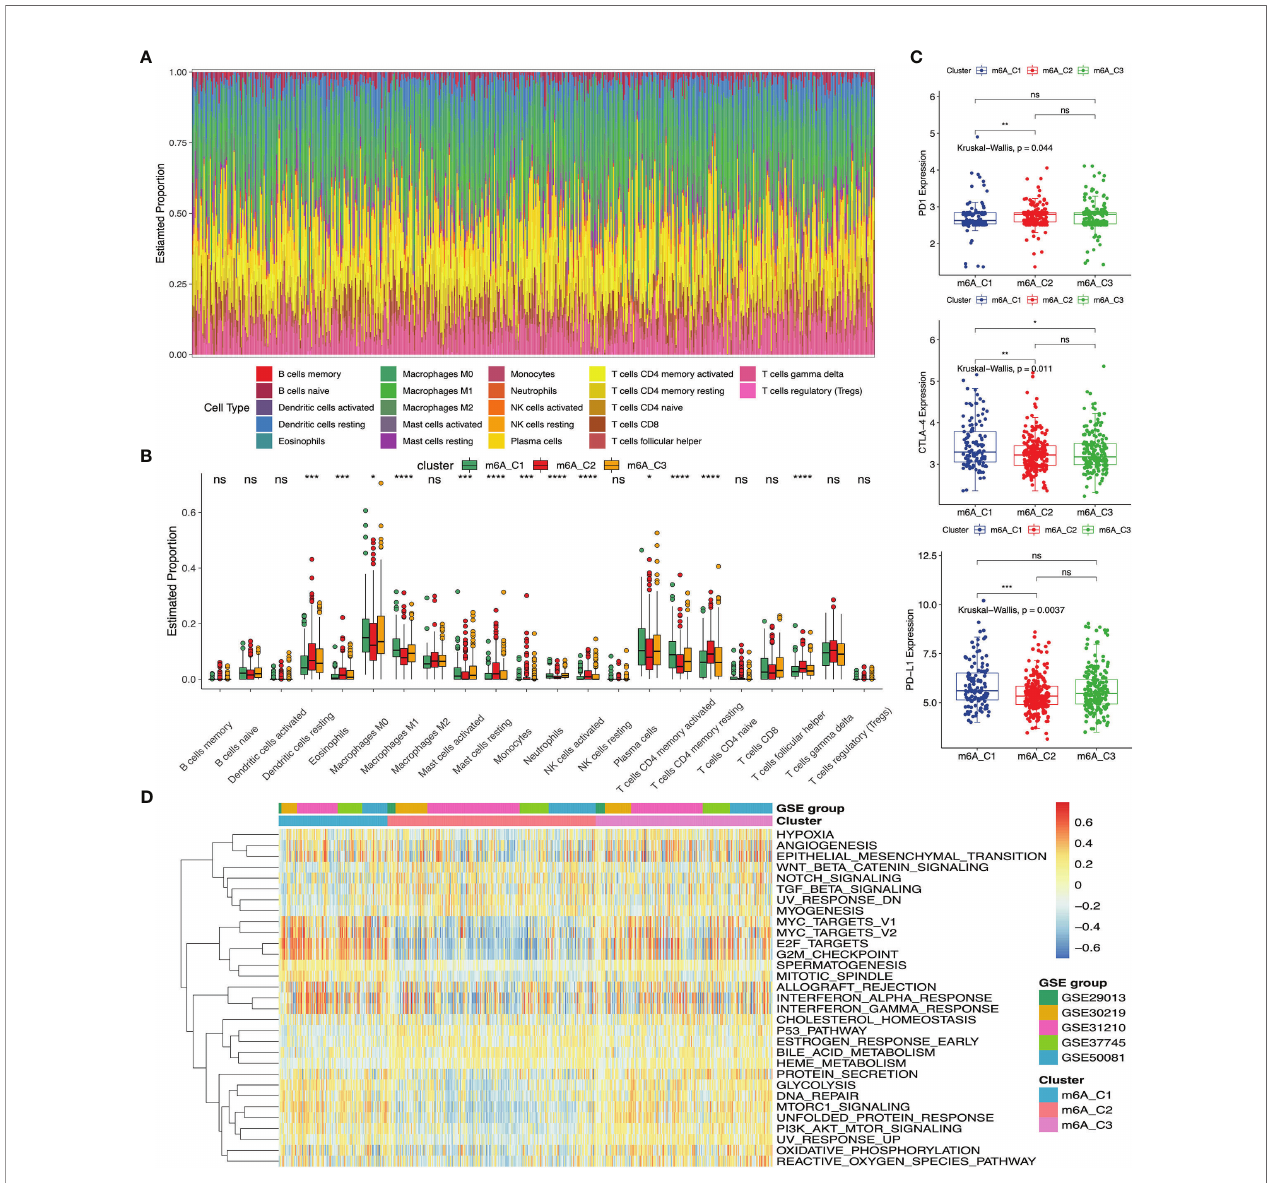
FIGURE 2 | The immune and biological landscape of three different clusters in meta-GEO cohort. (A) The results of the CIBERSORT analysis reveals the estimated proportion of different immune in fi ltrating cells. (B) The results of the CIBERSORT analysis reveals the estimated proportion of multiple immune in fi ltrating cells in three m 6 A clusters. Kruskal-Wallis H test was applied to compare the difference among three clusters (*P < 0.05; **P < 0.01; ***P < 0.001, ****P < 0.0001; ns, not signi fi cant). The estimated proportion of each immune cell was symbolized by the scattered dots. The median proportion was symbolized by the thick line. The interquartile range was represented by the range between the top and bottom of each box. (C) The difference of PD1, CTLA-4 and PD-L1 expression levels among three m 6 A clusters. (D) GSVA results were presented in the meta-GEO cohort among three clusters. The sample annotations of the heatmap were the composition of different GEO